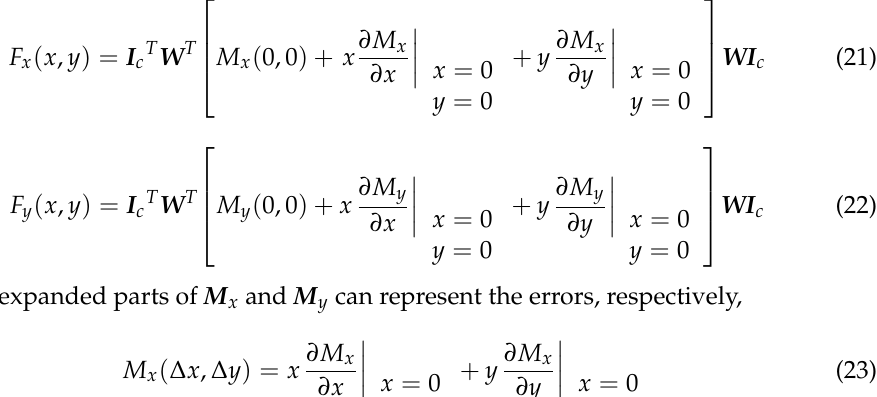
Figure 5. Improved current distribution control strategy proposed in this paper.